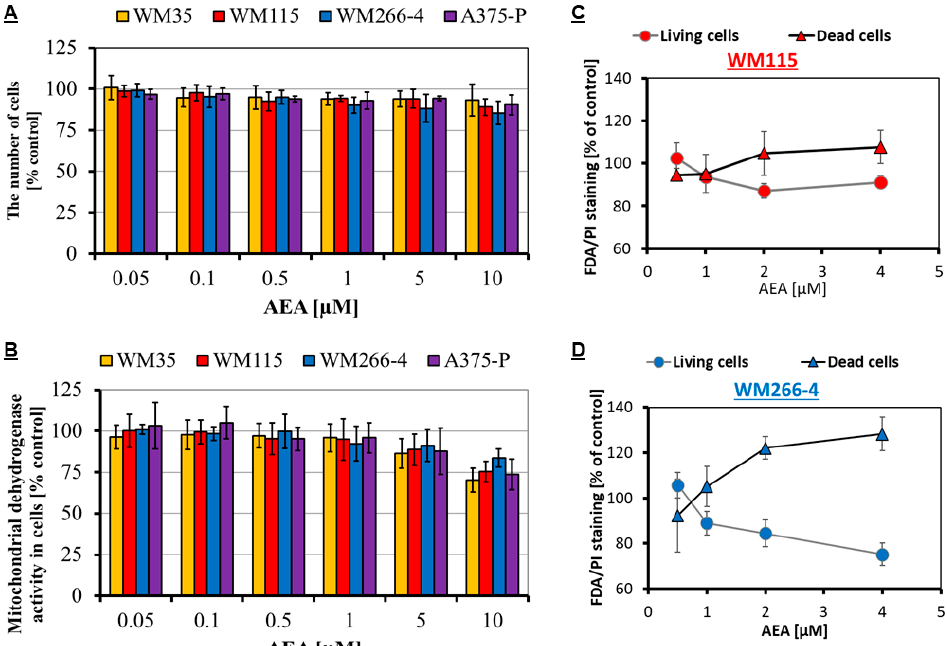
Figure 1. Influence of AEA on the number of melanoma cells calculated from CV assay ( A ), the mitochondrial dehydrogenase activity of melanoma cells checked by means of the MTT assay ( B ) and living/dead melanoma cell estimation based on the double FDA/PI staining for the primary VGP site WM115 cells—red ( C ) and metastatic WM266-4 cells—blue ( D ).